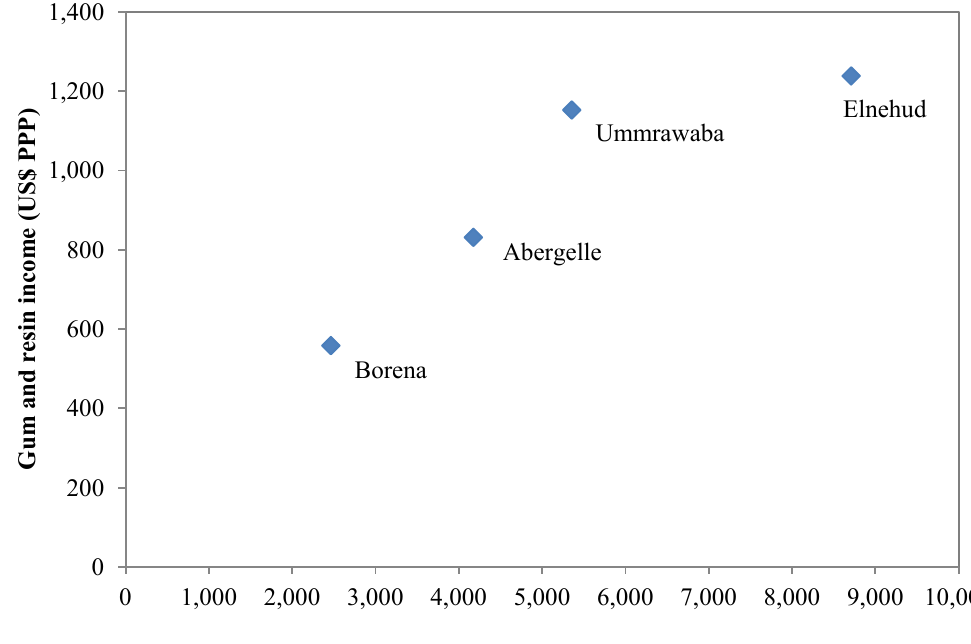
Figure 3. Cross-case comparison of the relation between total household income vs. gum and resin income (US$